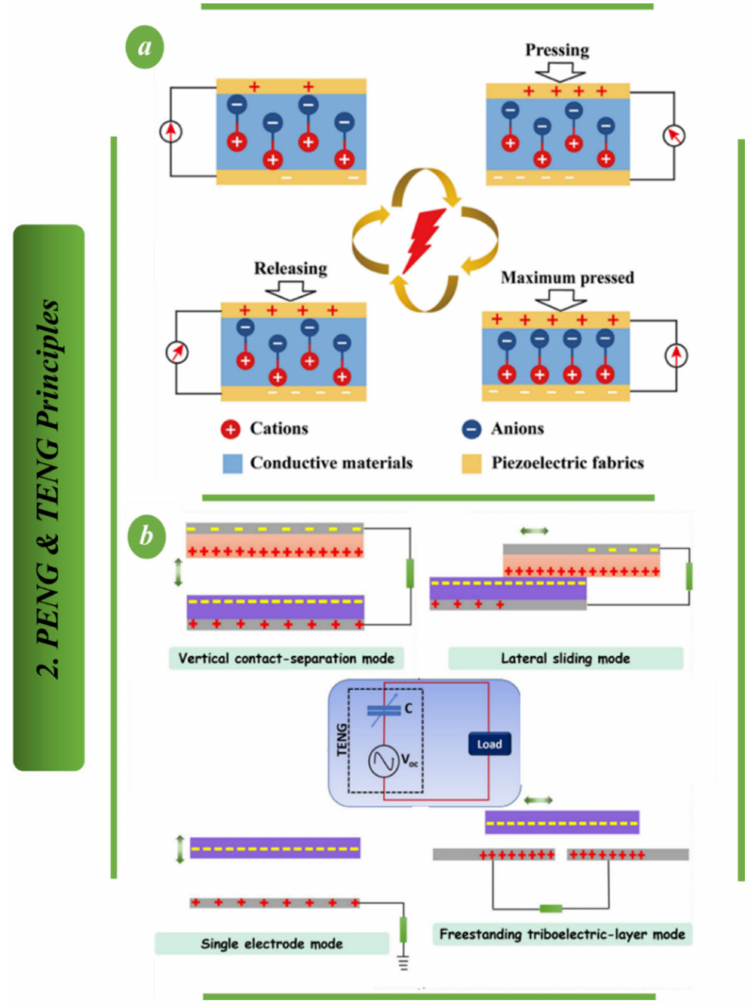
Figure 2. Principle of ( a ) piezoelectric [81] and ( b ) triboelectric nanogenerators